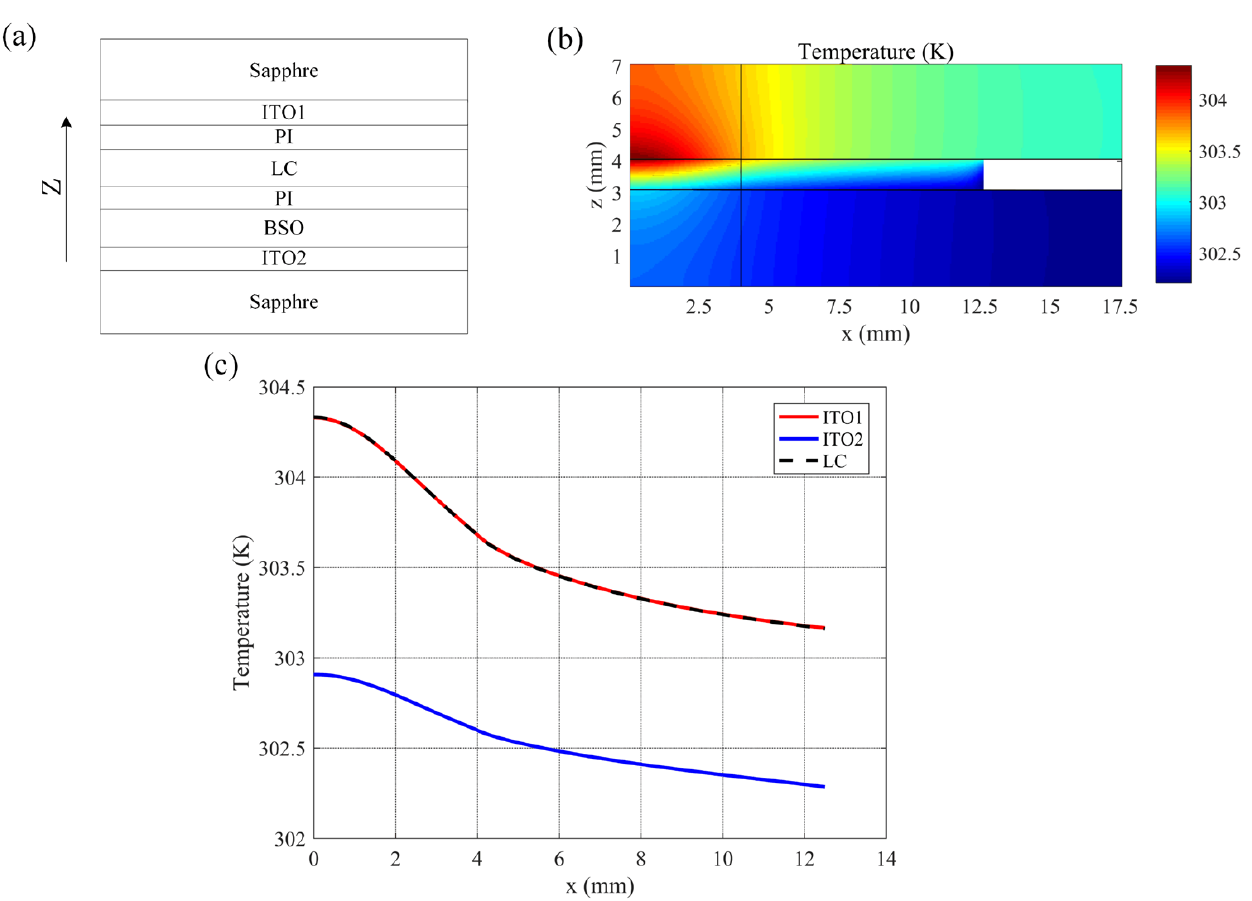
Figure 5. CW laser damage resistance test system. POL: polarizer, HWP: half wave plate, BS: beam splitter, NDF: neutral density filter, ANA: analyzer, L: lens.